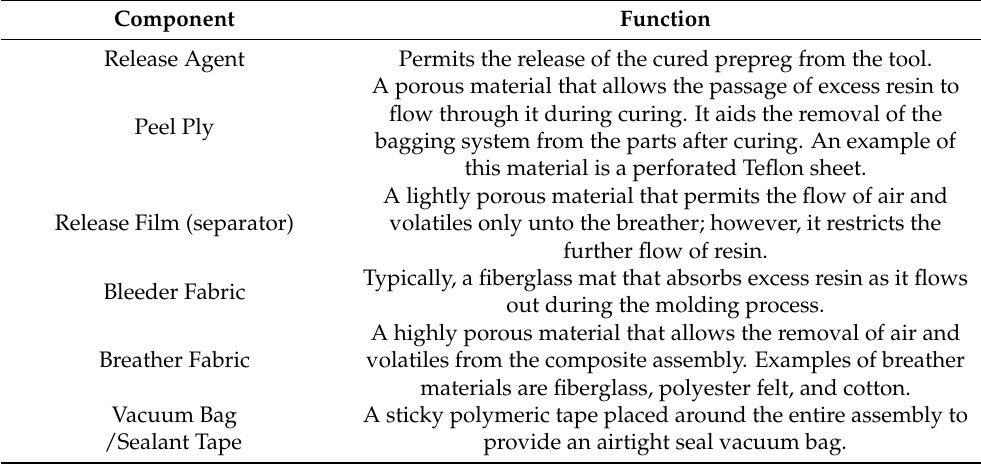
Table 1. Function of Vacuum Bagging